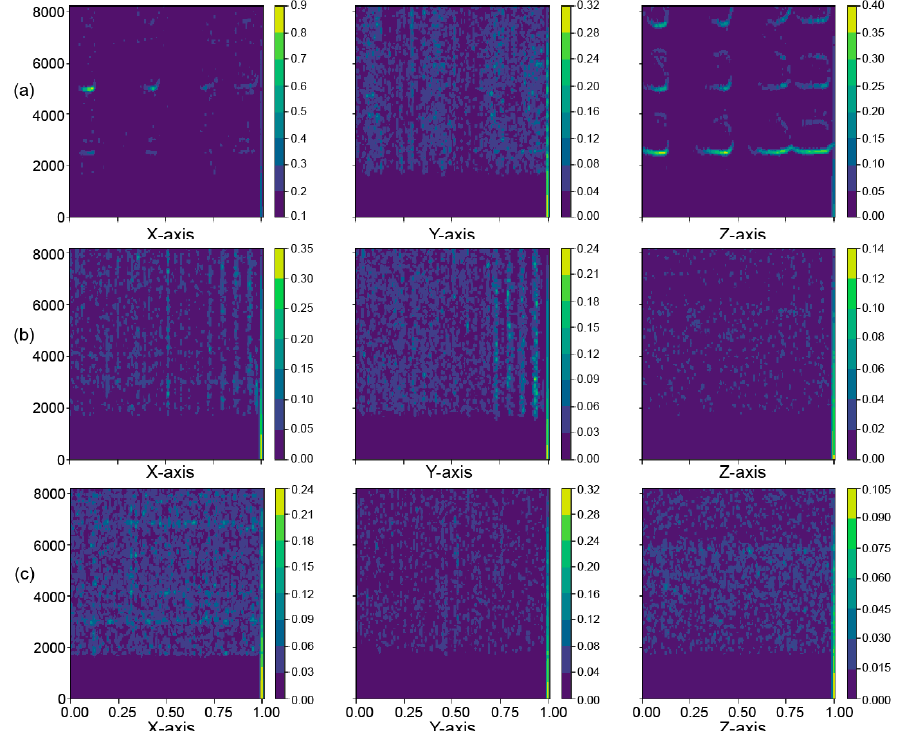
Figure 7. Time–frequency image after short-time Fourier transform. (a) Fine Gravel Sandstone, (b) Fine Sandstone, (c) Mudstone. Sandstone, ( c )